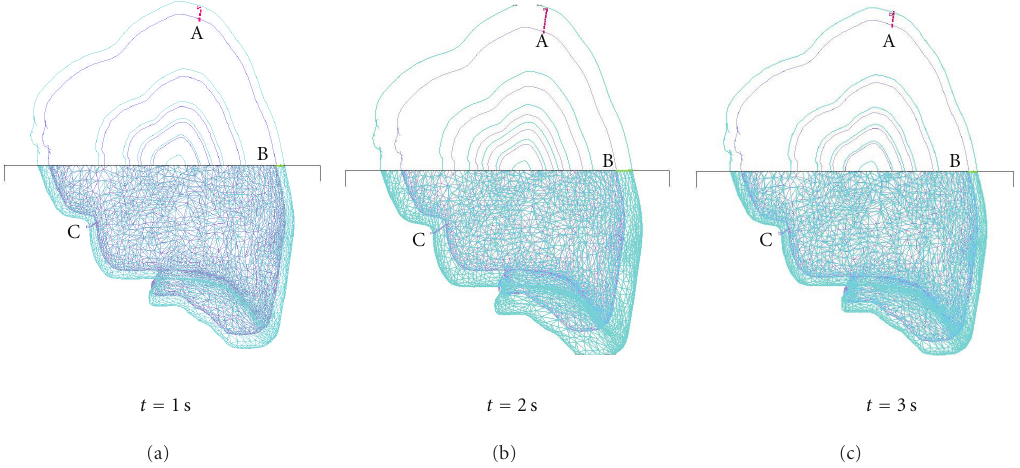
Figure 7: Predicted lung deformation with linear YM.